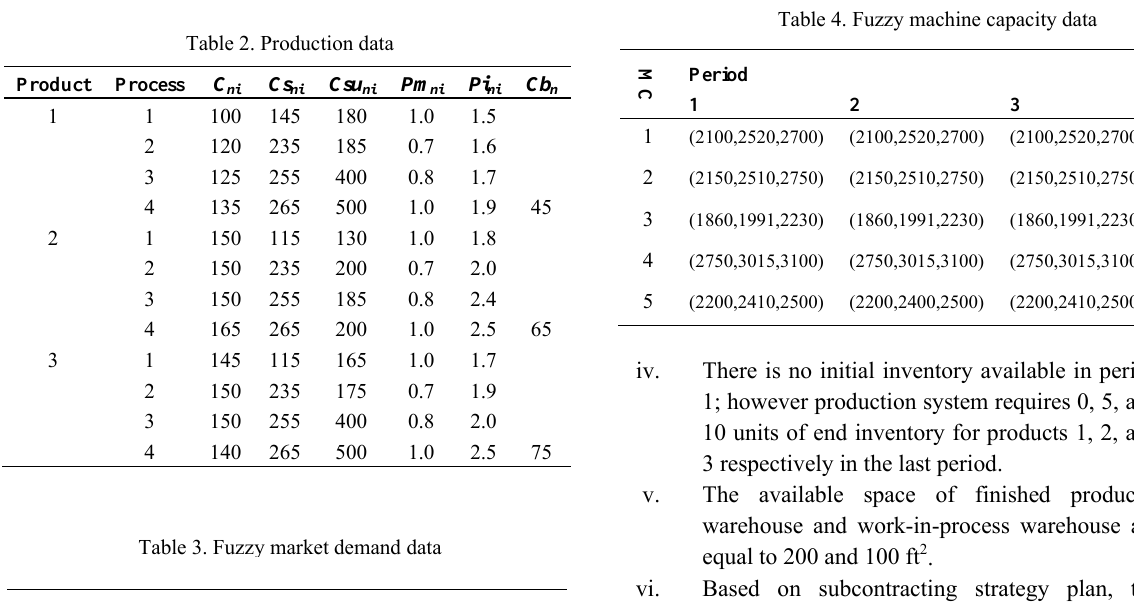
Fig. 5. Machine order visit